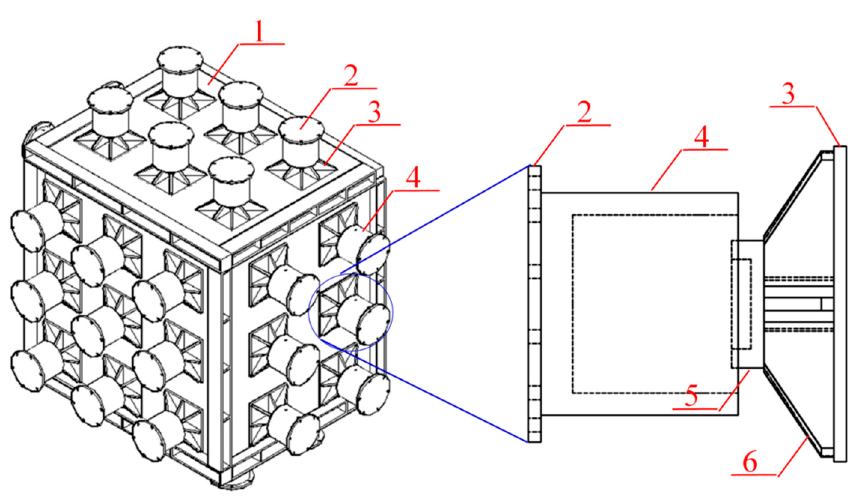
Figure 3. Three-dimensional design diagram of the true three-dimensional non-uniform loading/unloading device. 1: Model loading steel plate; 2: steel corner fitting; 3: force transfer loading module bottom plate; 4: hydraulic jack; 5: force transfer loading module top plate; and 6: force transfer reinforcing rib plates.